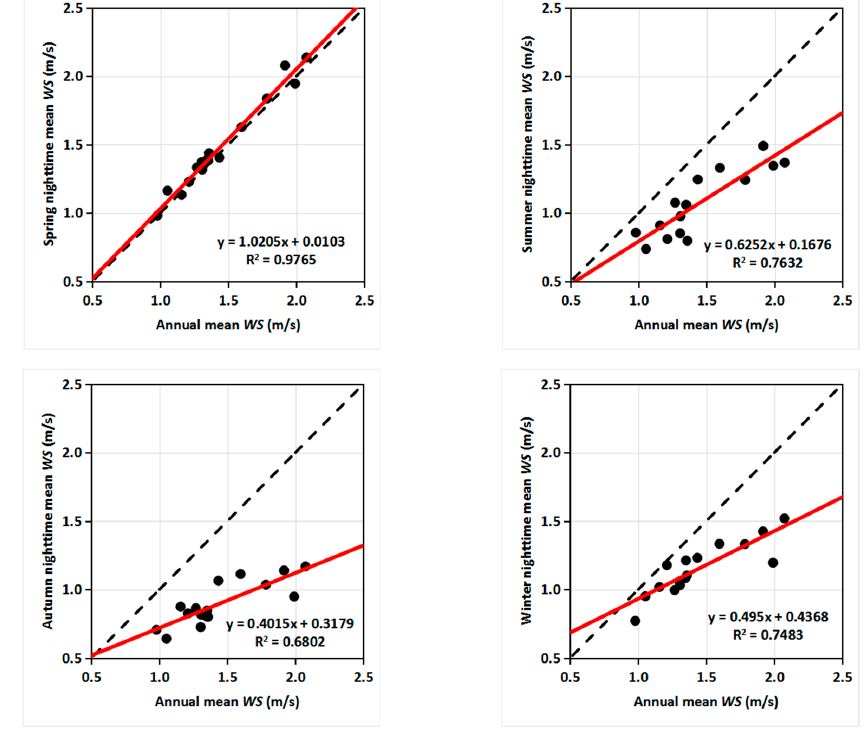
Figure 6. Nocturnal mean wind speed at the 16 stations and the local climate zone ventilation performance sequences in four